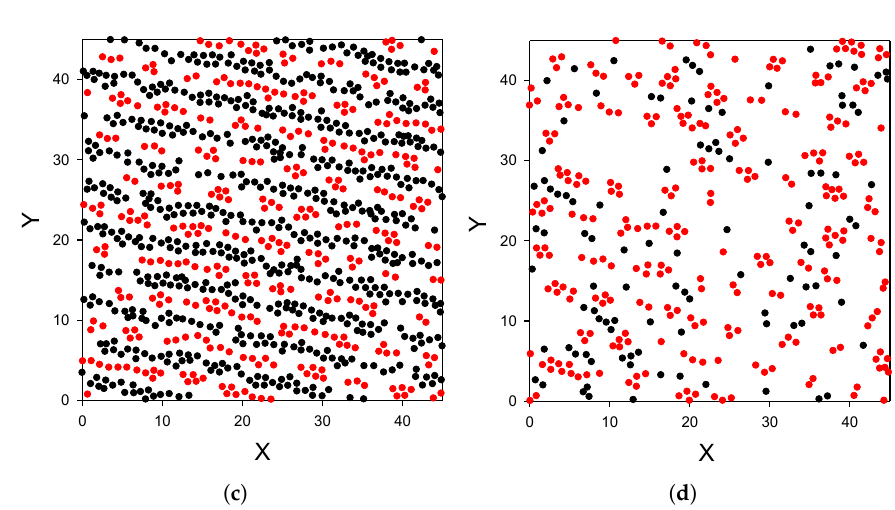
Figure 3. Distribution of the particles near a surface attracting the first and repulsing the second ρ 1 = 0.0012). Particle–particle component for ¯ T = 0.25 and ρ g = 0.0023 (volume fraction π 6 interactions are given by (1) and (2) for like and different particles, and wall–particle interactions are given by (3) and (4) for the first and the second component, respectively, with γ attr = 4 and γ rep = 16. Projections on the ( x , y ) plane of the particles in the layers 0 < z < 1.6, 1.6 < z < 2.6, 2.6 < z < 3.6 and 3.6 < z < 4.6 are shown in panels ( a – d ), respectively, for a representative configuration. Red and black circles represent particles of the first and the second kind, respectively. X , Y and z are in units of the particle diameter a . Only a part of the simulation box is shown. Simulations were performed for the initial number of particles N 0 = 6050. Very similar results were obtained for N 0 =